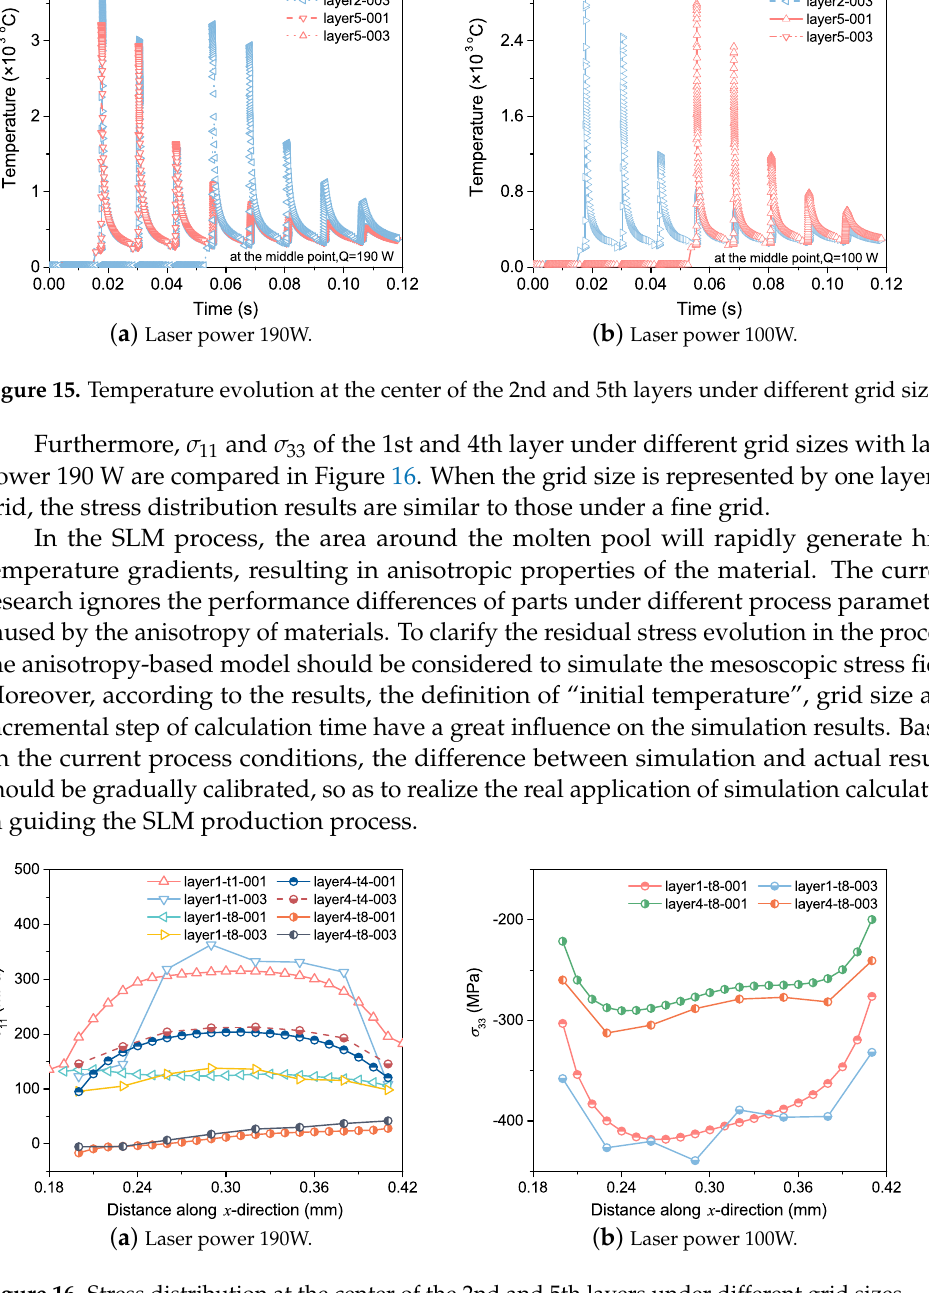
Figure 16. Stress distribution at the center of the 2nd and 5th layers under different grid